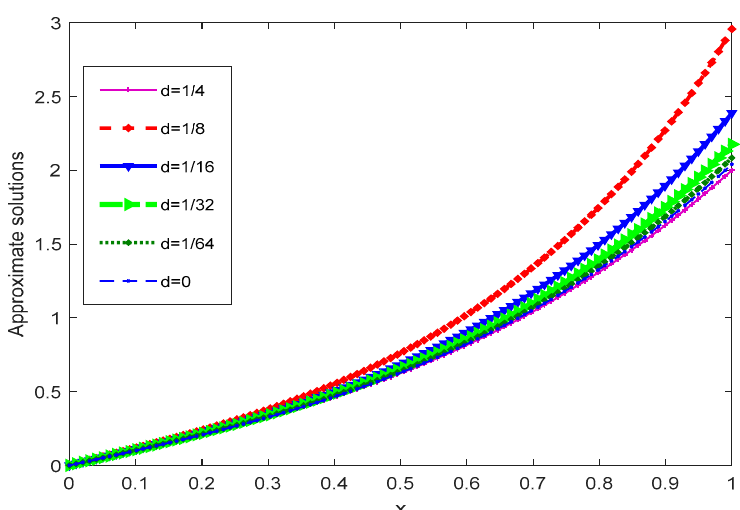
, and 𝑅 = 4. Figure 8. Plot of MAE of Example 4 for α = 2 , and R = 4. (cid:2871) 3